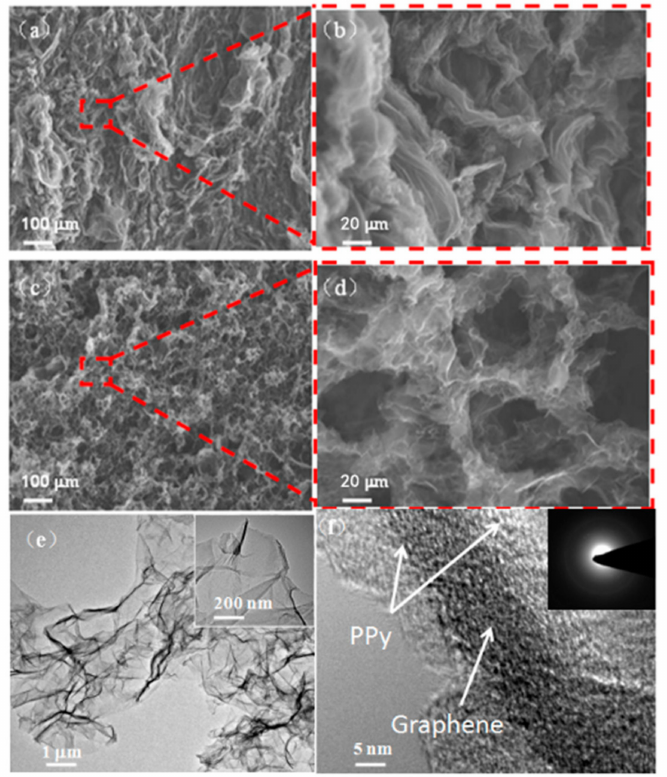
Figure 4. Scanning electron microscopy (SEM) and transmission electron microscopy (TEM) images of the interior microstructures of rGO-PPy composite hydrogels. ( a , b ) SEM images of the rGO-PPy obtained from Py concentration of 0.1 mM. ( c , d ) SEM images of the rGO-PPy obtained from Py concentration of 1 mM. ( e , f ) TEM images of the resulting rGO-PPy. The inset in ( e ) is the enlarged view of the edge. The inset in ( f ) is the selected area electron diffraction pattern of ( e ).